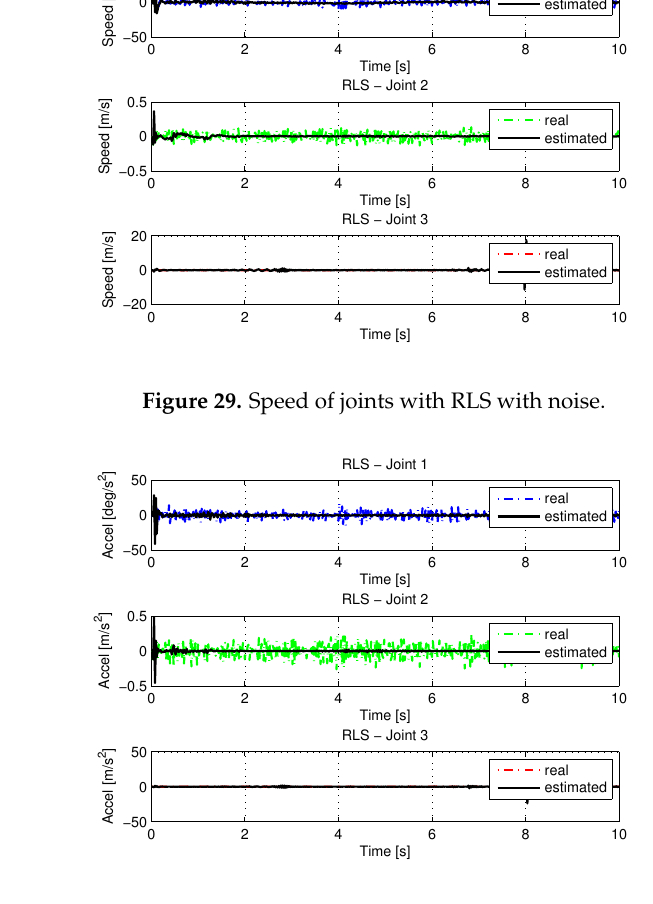
Figure 30. Accelerations of joints with RLS with noise.